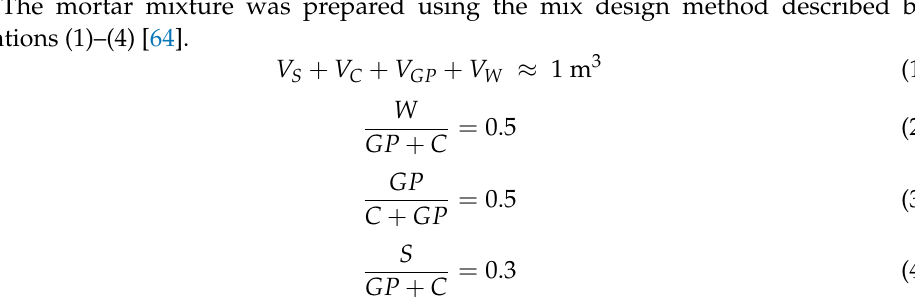
Figure 3. Particle-size distribution of the cements and glass powder used. Table 2. Particles size and density of binders used.